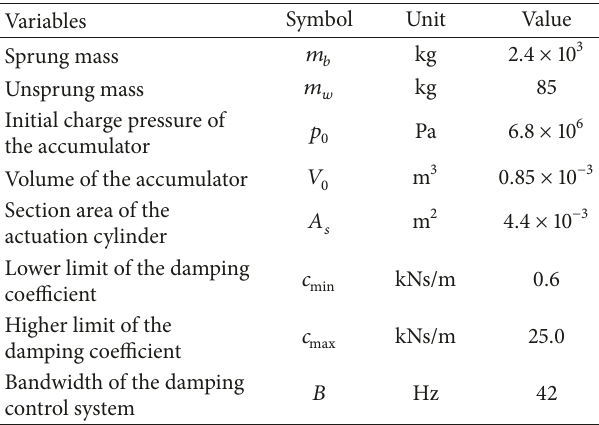
Table 1: Initial values of single-wheel suspension.